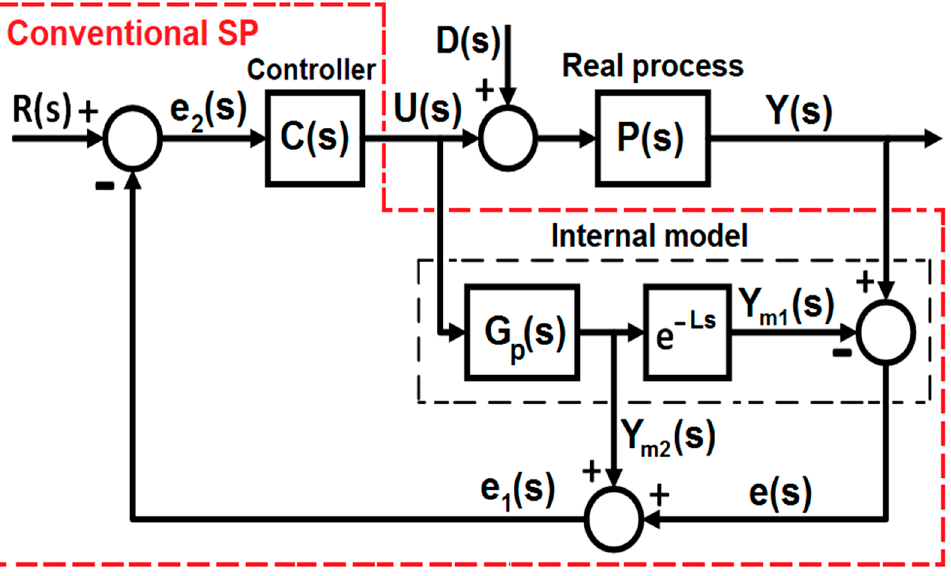
Figure 8. Conventional structure of the SP.